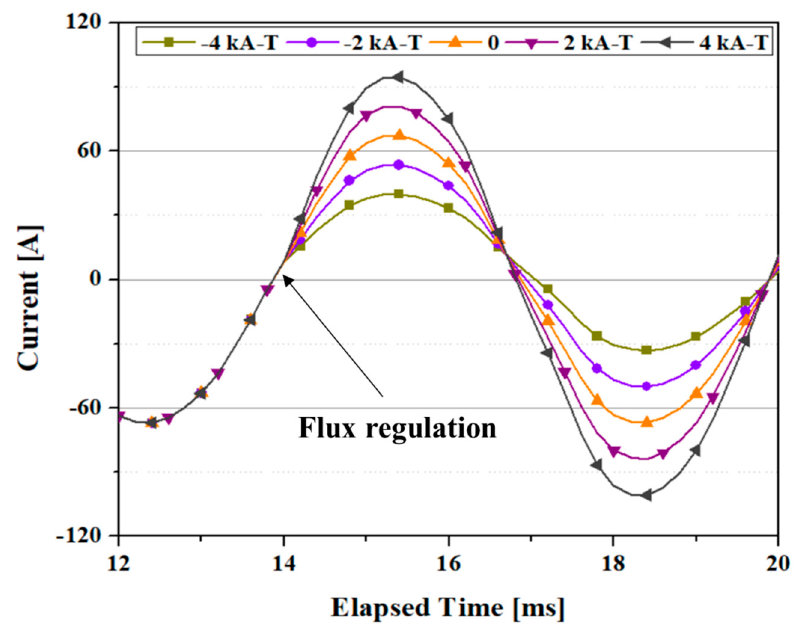
Figure 21. Phase current of Phase C in the resistance-load condition according to the MMF of the additional field winding.